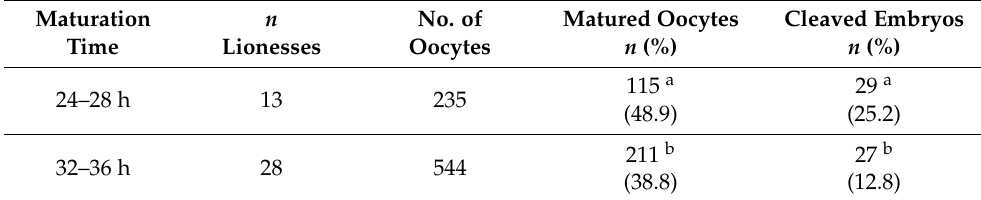
Table 6. Effects of the duration of IVM in African lion